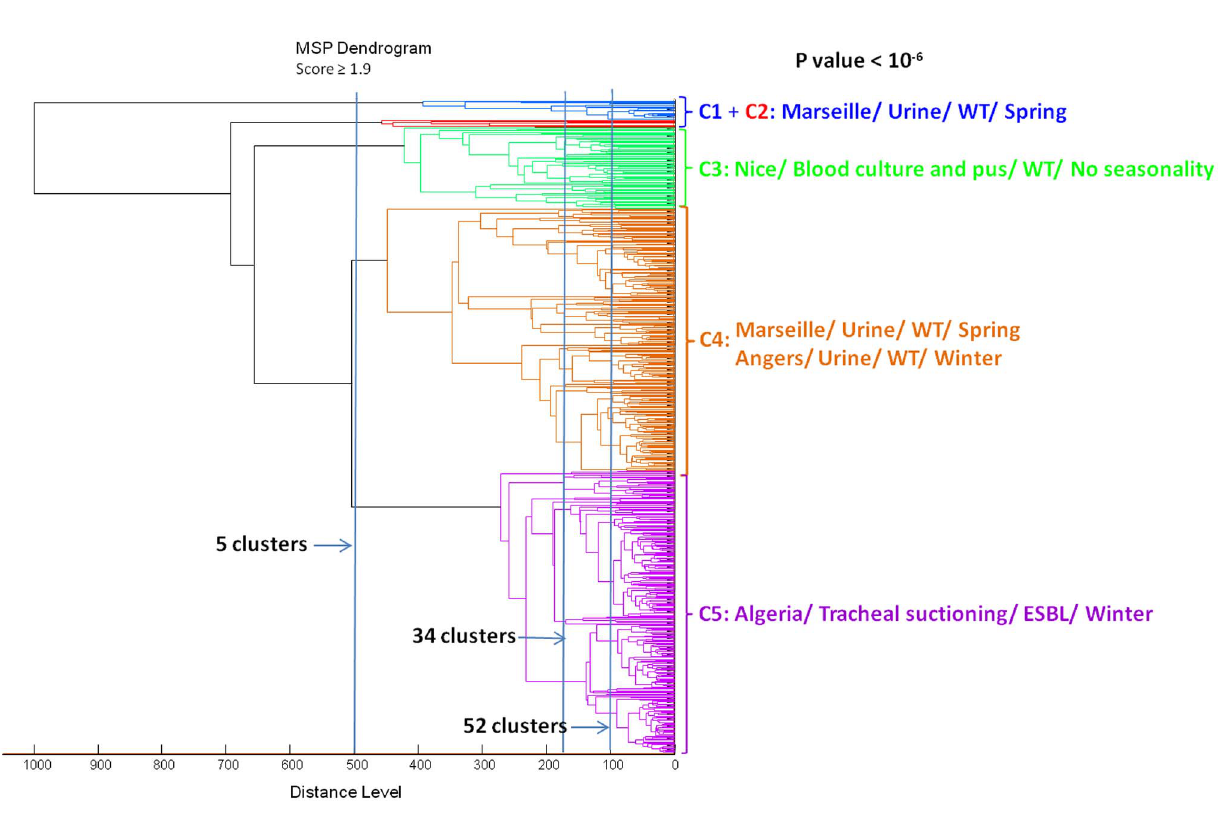
Figure 1. Geographic location of hospitals implicated in this study. 1: Tlemcen, 2: Sidi Bel Abbes, 3: Oran, 4: Annaba, 5: Marseille, 6: Nice, 7: Angers.